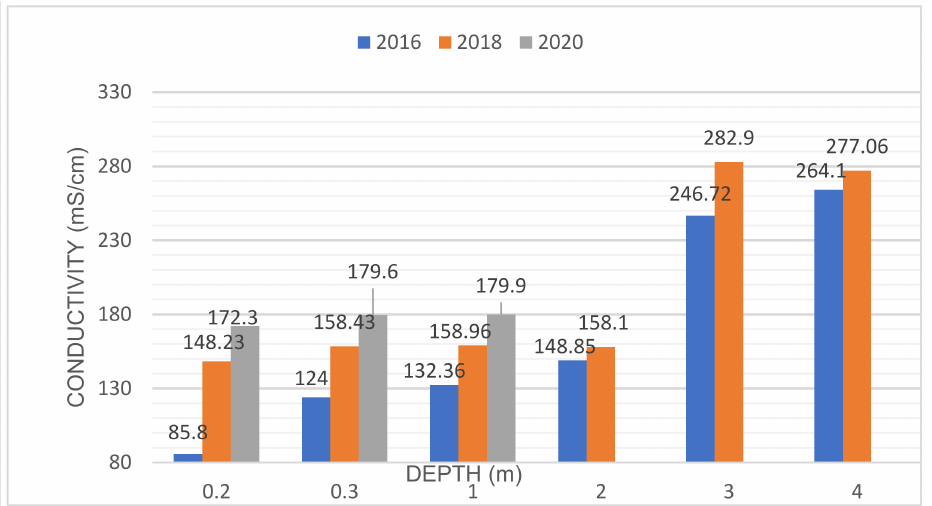
Figure 9. Conductivity levels at several depths of Lake